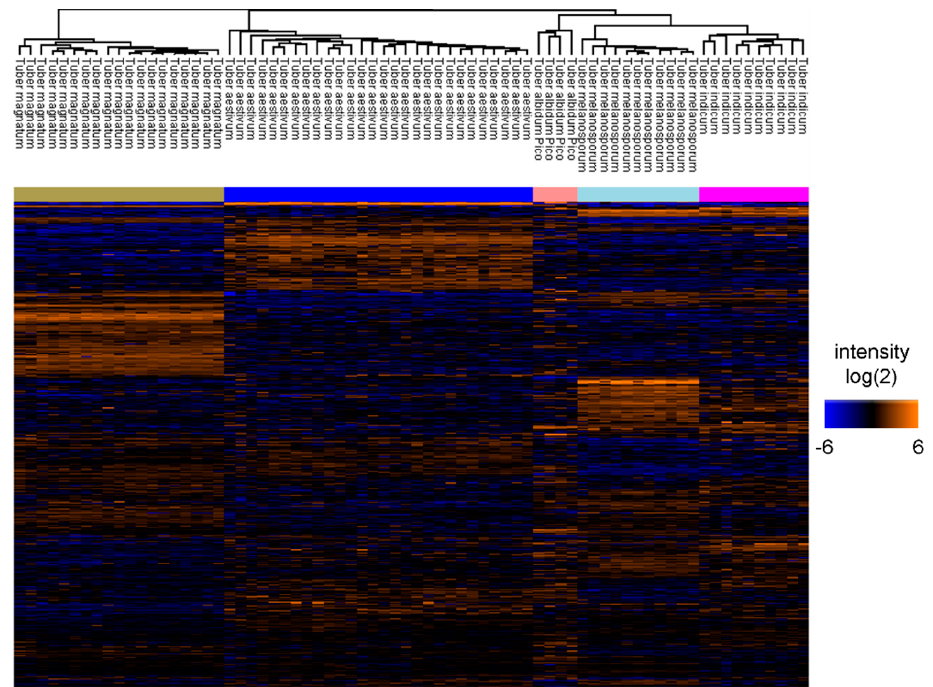
Figure 3. Heat map using ANOVA [21] test with 5% FDR displaying significant protein abundance in different truffle species after hierarchical clustering. The quantities of the different proteins of the truffle species were compared against each other. The heat map was generated by Perseus and displays log2 protein areas for the 2066 ANOVA significant proteins identified in all samples. Each column in the heat map represents a different sample. Each line represents a protein. Orange lines correspond to proteins with a high abundance within the comparison of the five truffle species, blue lines with proteins of a low abundance.